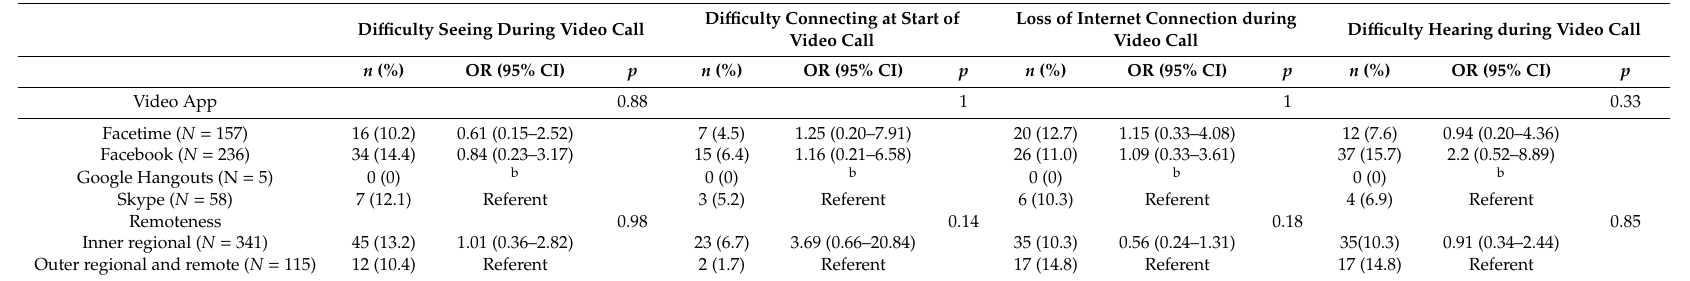
Table 3. Factors associated with connectivity issues during the video sessions a